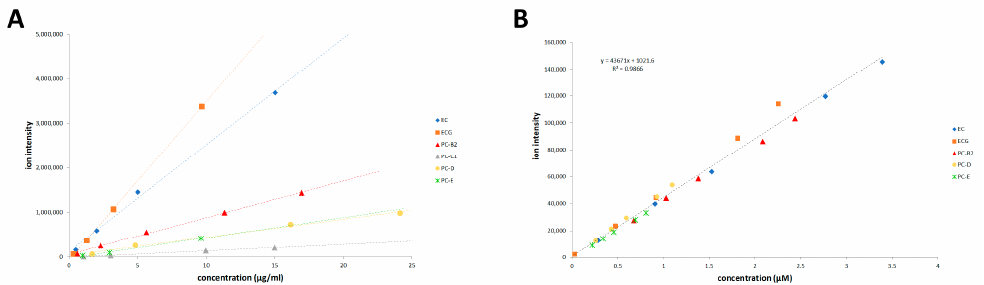
Figure 4. ESI Q-TOF MS matrix-matched calibration curve obtained from linear regression of a single analyte ion volume versus concentration expressed as µ g/mL (Plot A ) and cumulative data from epicatechin (EC), epicatechin gallate (ECG), procyanidin B2, D, and E expressed as µ molar concentration (Plot B ).